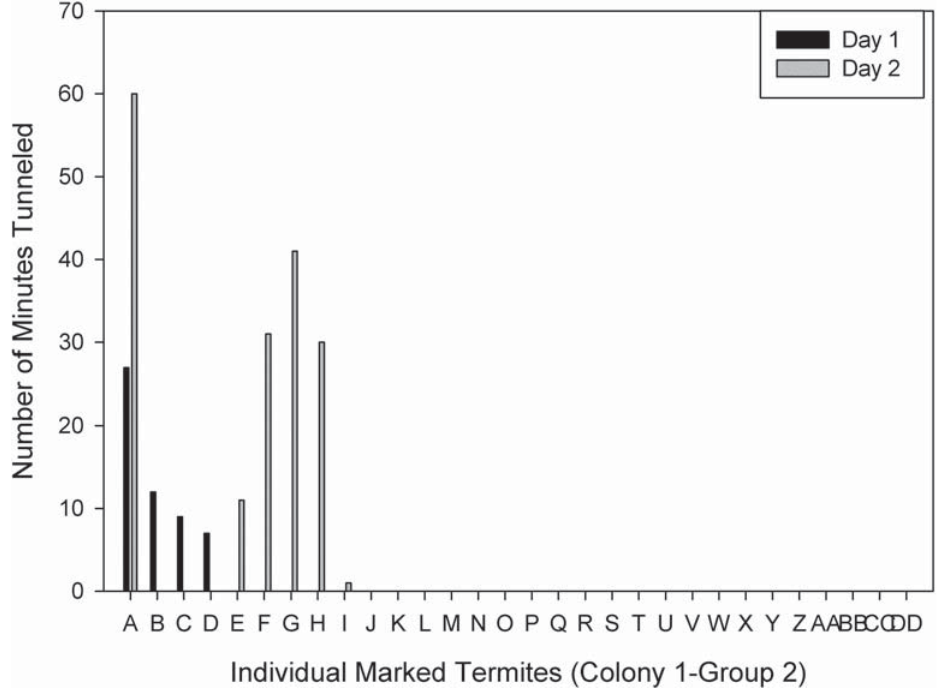
Colony 1-Group 2 on Day 1 and Day 2.